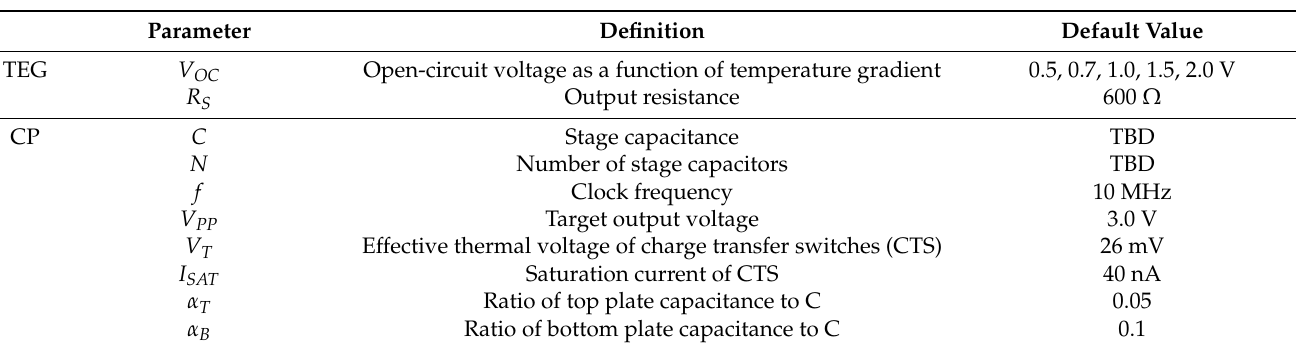
Table 1. Definition of circuit parameters.